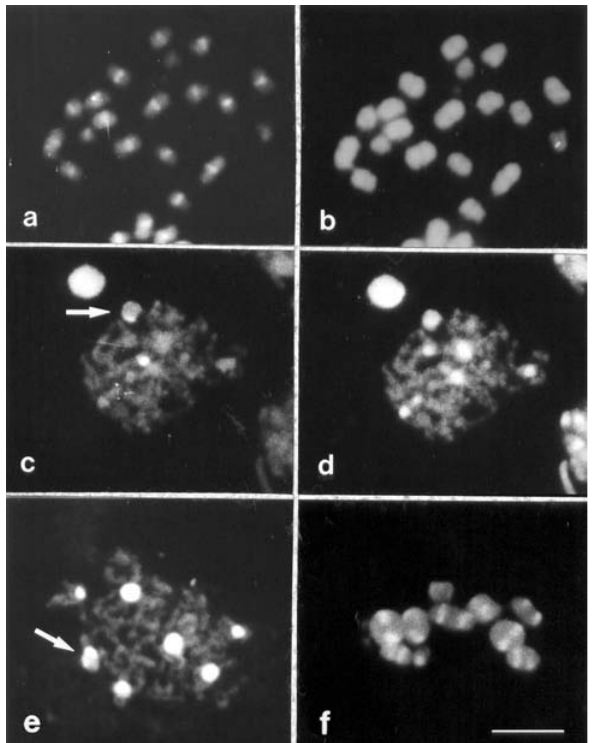
Figure 2 - Constitutive heterochromatin (CH) distribution pattern in the five species studied. C-bands in a spermatogonial metaphase of G. borelli (a). Metaphase I of P. pallidipennis (b). Pachytene of M. festiva (c), note the heterochromatic associations. Diplotene and metaphase I of L. ebenus (d) and S. s. hirtus (e). The arrowheads point to an almost completely heterochromatic sex bivalent. The arrows indicate the presence of a termi- nal CH block in L. ebenus (d) and the absence of labeling in an autosomal bivalent of S. s. hirtus (e). Bar = 5 (cid:1) m.